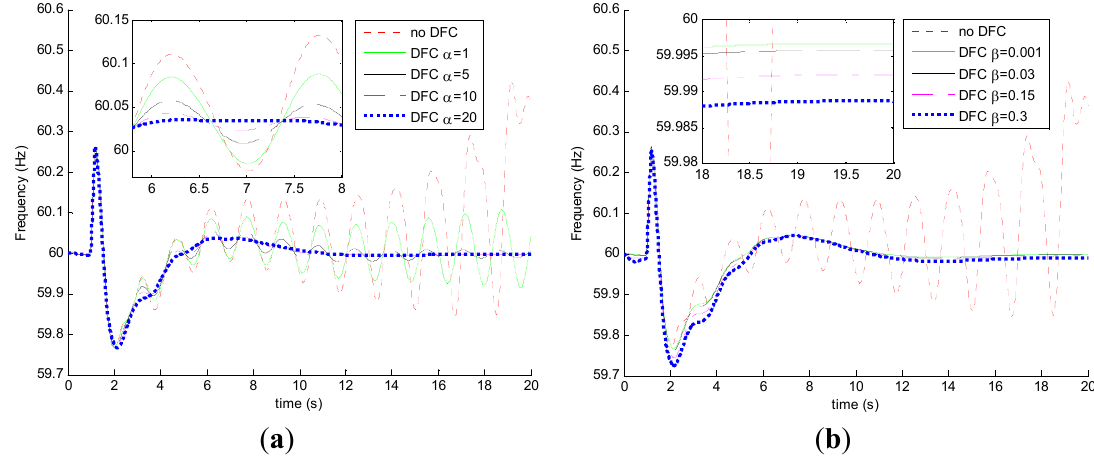
Figure 7. Comparisons of the frequency deviations under different controller parameters with a short-circuit fault ( a ) different α ; ( b ) different β ( α = 20).